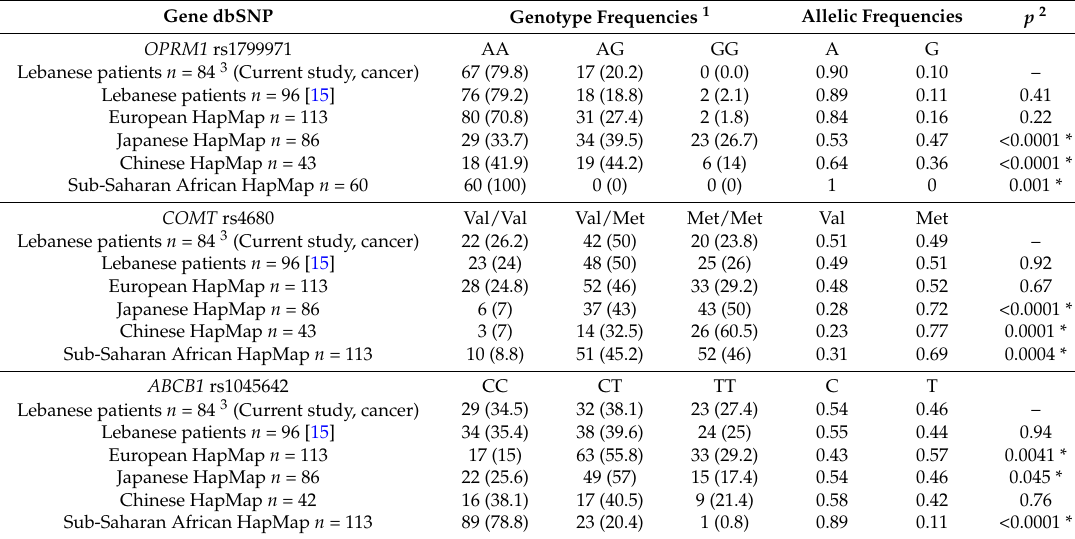
Table 2. Genotype and allele frequencies of OPRM1 , COMT , and ABCB1 variants in our population. Comparison with previously published